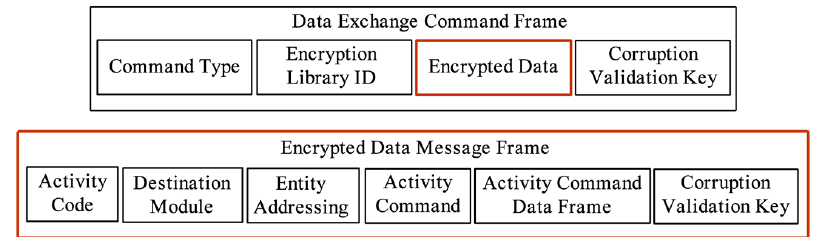
Figure 5. HSS module data exchange command frame.